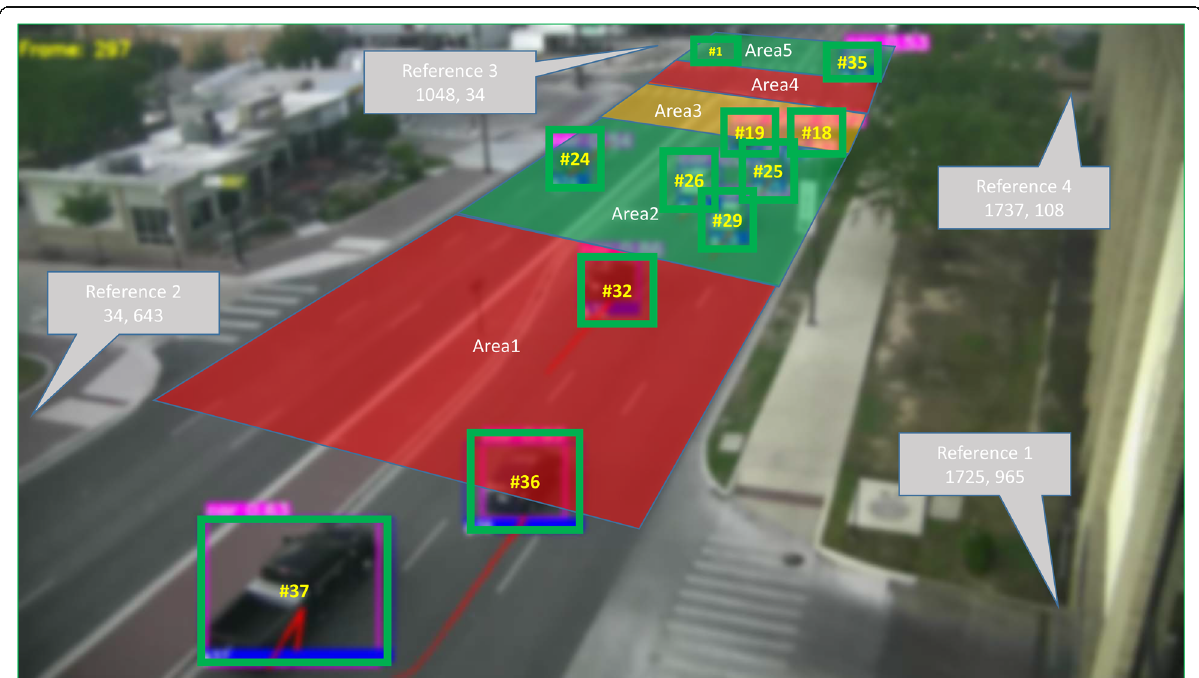
Fig. 2 Reference points and Areas 1 through 5 in the camera view. Each bounding box indicates a detected vehicle with assigned ID # (image is blurred for privacy